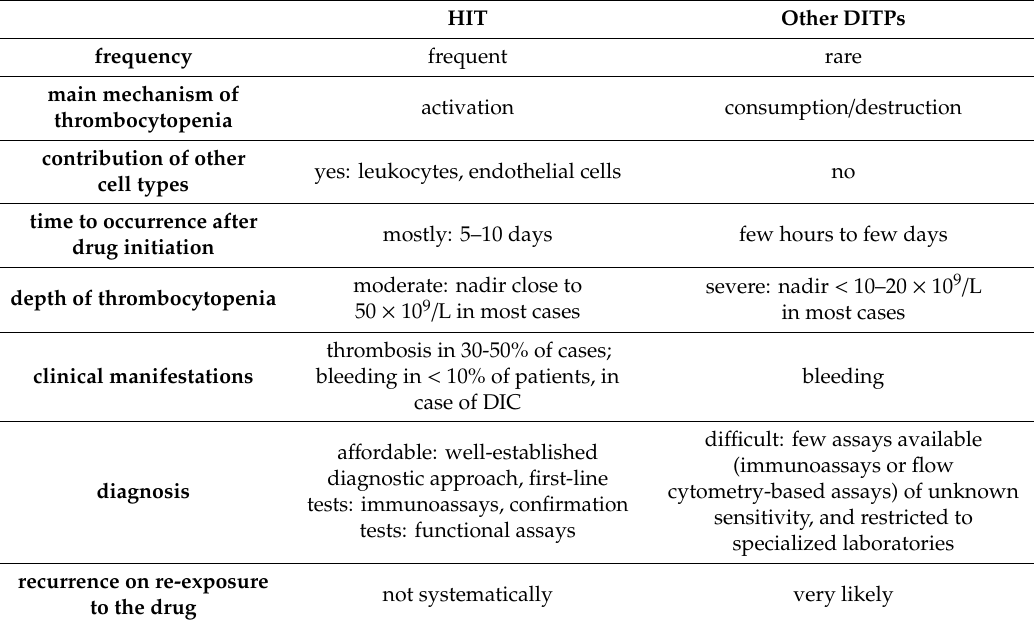
Table 2. Main di ff erences between heparin-induced thrombocytopenia (HIT) and other